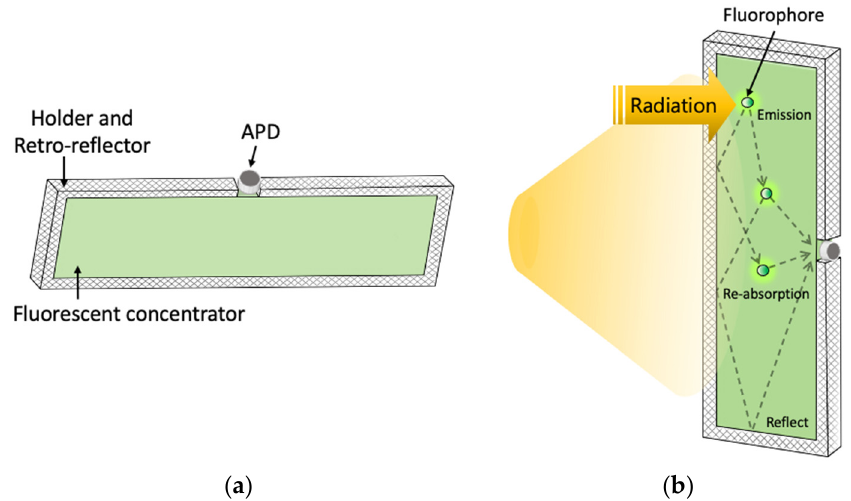
Figure 2. ( a ) Design of license-plate-shaped receiver; ( b ) schematic diagram of the physical process of a fluorescent concentrator.